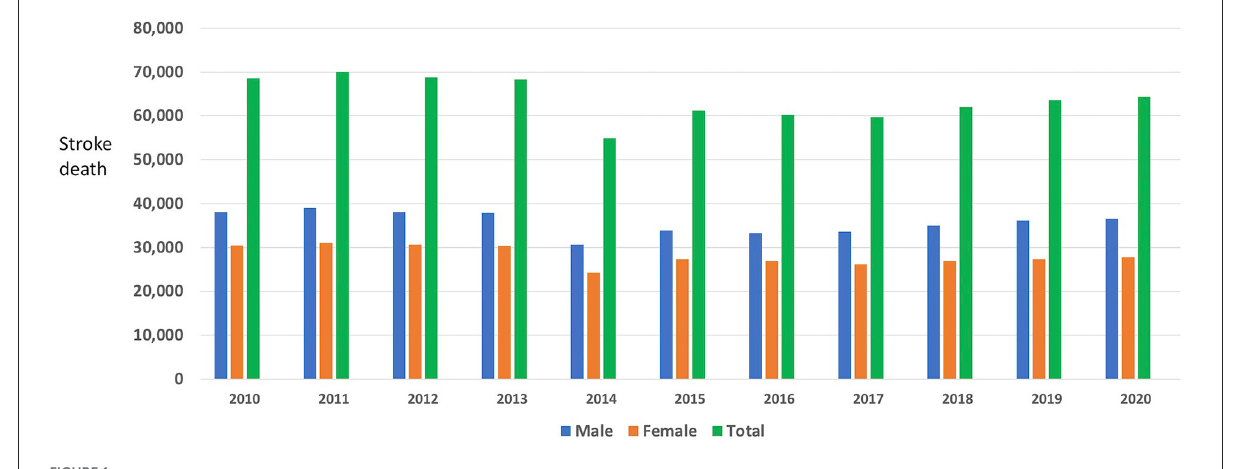
FIGURE1 Philippine stroke mortality 2010–2020 (4,